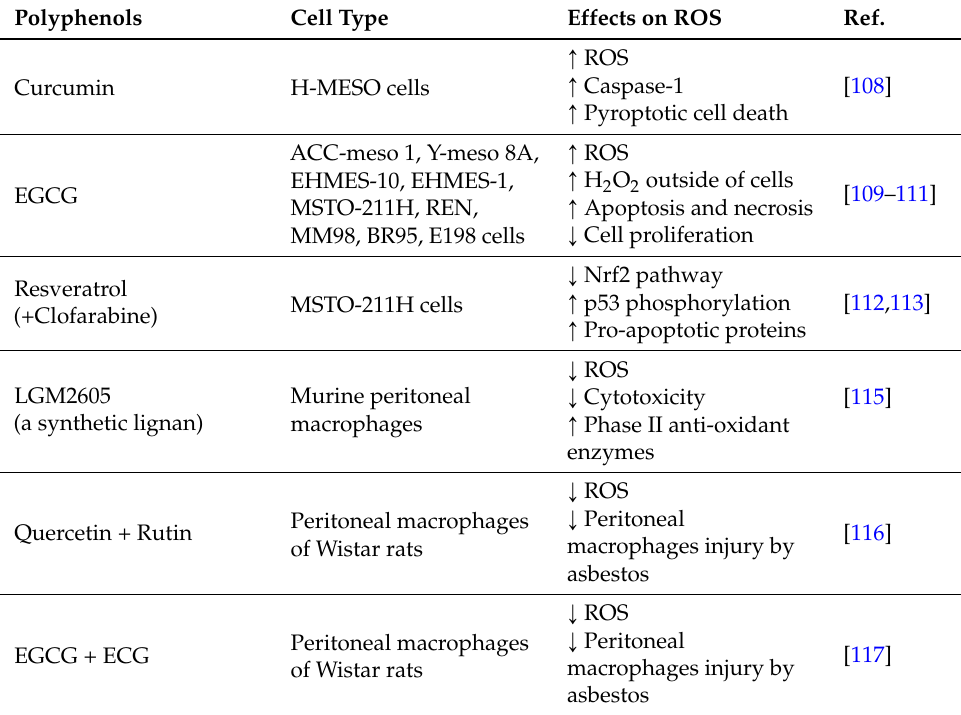
Table 1. Effects of polyphenols on ROS production and scavenging in